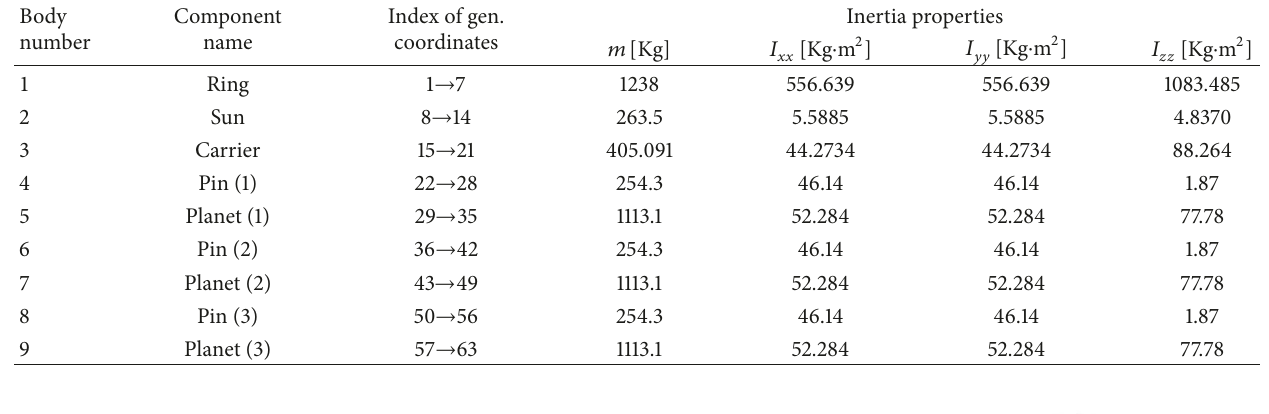
Table 3: Body index of planetary stage.